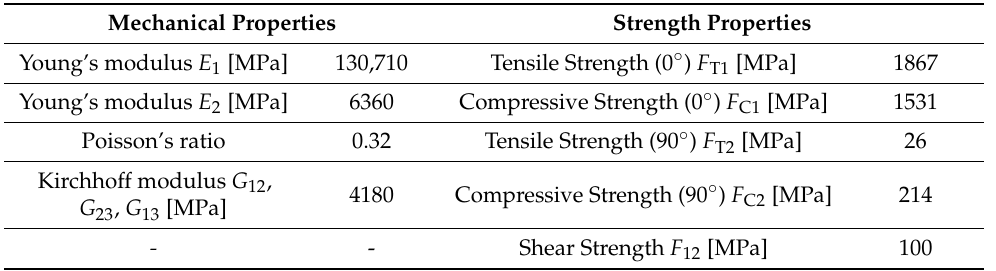
Table 1. The mechanical and strength properties of the composite material [56].